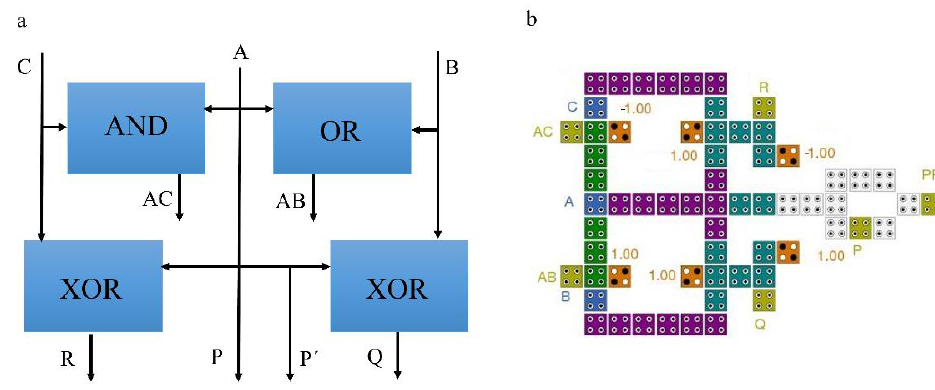
Figure 5. The QCA schematic layout of a reversible test circuit. Figure 5. ( a ) The schematic of a reversible test circuit, ( b ) The QCA layout of a reversible test